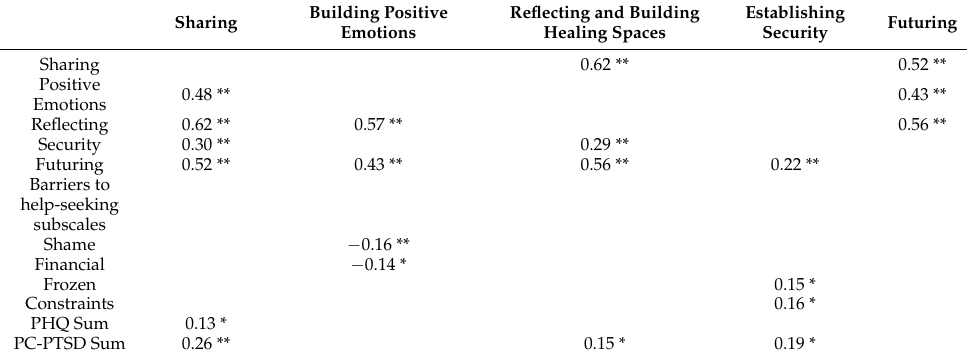
Table 5. Correlation